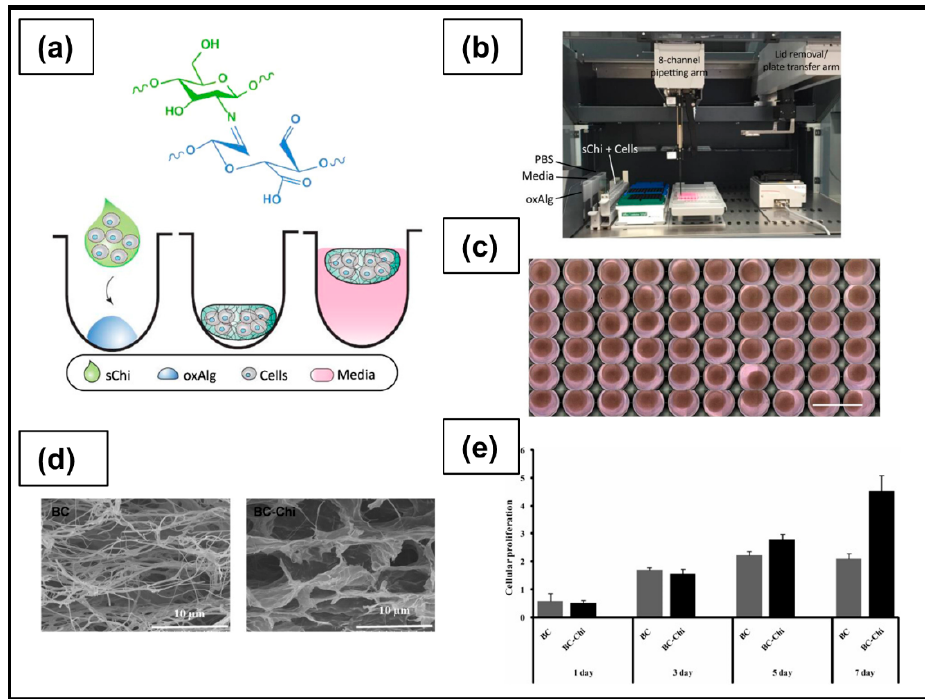
Figure 9. Chitosan and cellulose hydrogels. ( a ) Chemical structure of sChi (green)-oxAlg (blue) unit, and schematic representation of cell seeding process in U-bottom 96-well plates; ( b ) setup for automated seeding of cells via Tecan Freedom EVO liquid handling station; ( c ) cell-seeded scaffolds at day 1 (scale bar = 10 mm) [197]. ( d ) SEM morphology of BC and BC-Chi scaffolds; ( e ) A2780 cell proliferation on BC and BC-Chi scaffolds for 1, 3, 5, and 7 days